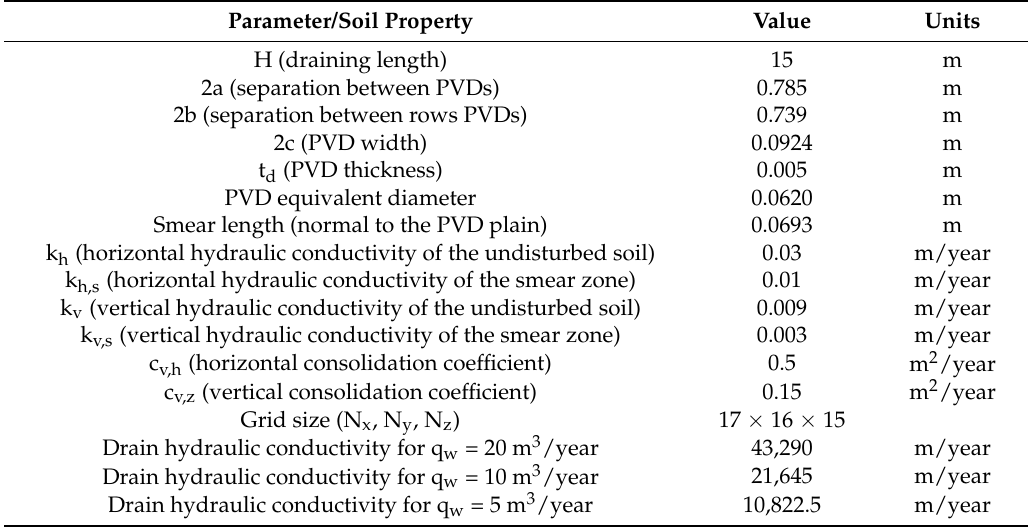
Table 5. Geometry and physical properties of the problem.